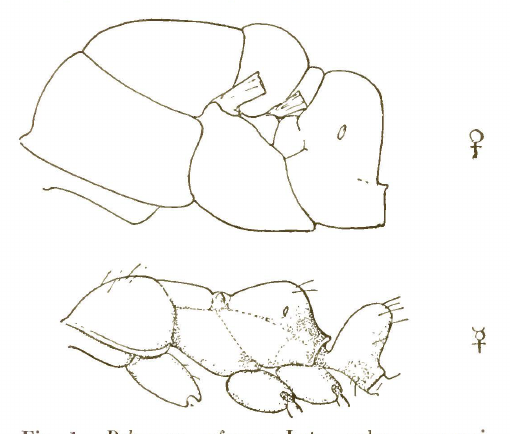
Fig. 1. Polyergus rufescens Latr., subsp. samura£ subsp. nov. Profile of thorax in female and worker. posterior border; the mandibles narrow and long, curved inward, pointed, with a minutely dentate masticatory margin, clypeus triangular, broad, and flat, its anterior margin nearly straight; frontal area small, distinctly broader than long, its posterior suture rounded, anterior suture nearly straight; median line long and distinct; antenna} carinre not distinct; antennre rather short, the scapes just reaching to the posterior border of the head, somewhat swollen apically, the flagellum long, filiform; ocelli very